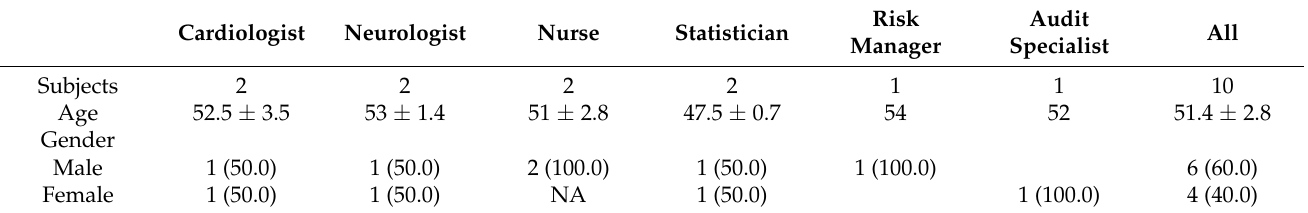
Table 1. Demographic characteristics. Mean ± standard deviation was used to describe continuous variables; proportions (numbers and percentages) were used to describe categorical variables.